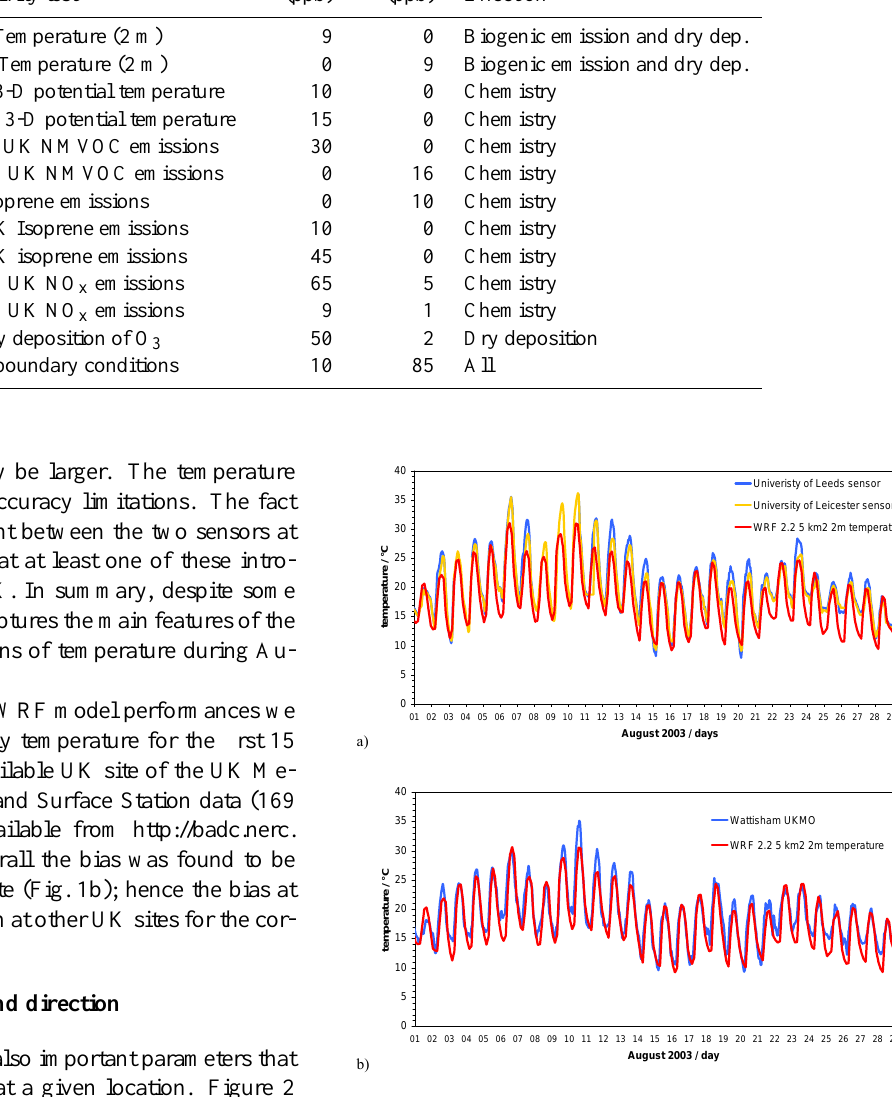
Fig. 1. Measured (blue, orange) and modelled (red) hourly surface temperature ( ◦ C) during August 2003 at (a) Writtle TORCH cam- paign, and (b) Wattisham UK Met Office weather station. For Writ- Figure 1: Measured (blue, orange) and modelled (red) hourly surface temperature (°C) during tle, measurements from two different sensors are shown. Model August 2003 at (a) Writtle TORCH campaign, and (b) Wattisham UK Met Office weather results are from the WRF 5 × 5km 2 grid-square containing the station. For Writtle, measurements from two different sensors are shown. Model results are from the WRF 5 × 5 km 2 grid-square containing the site.